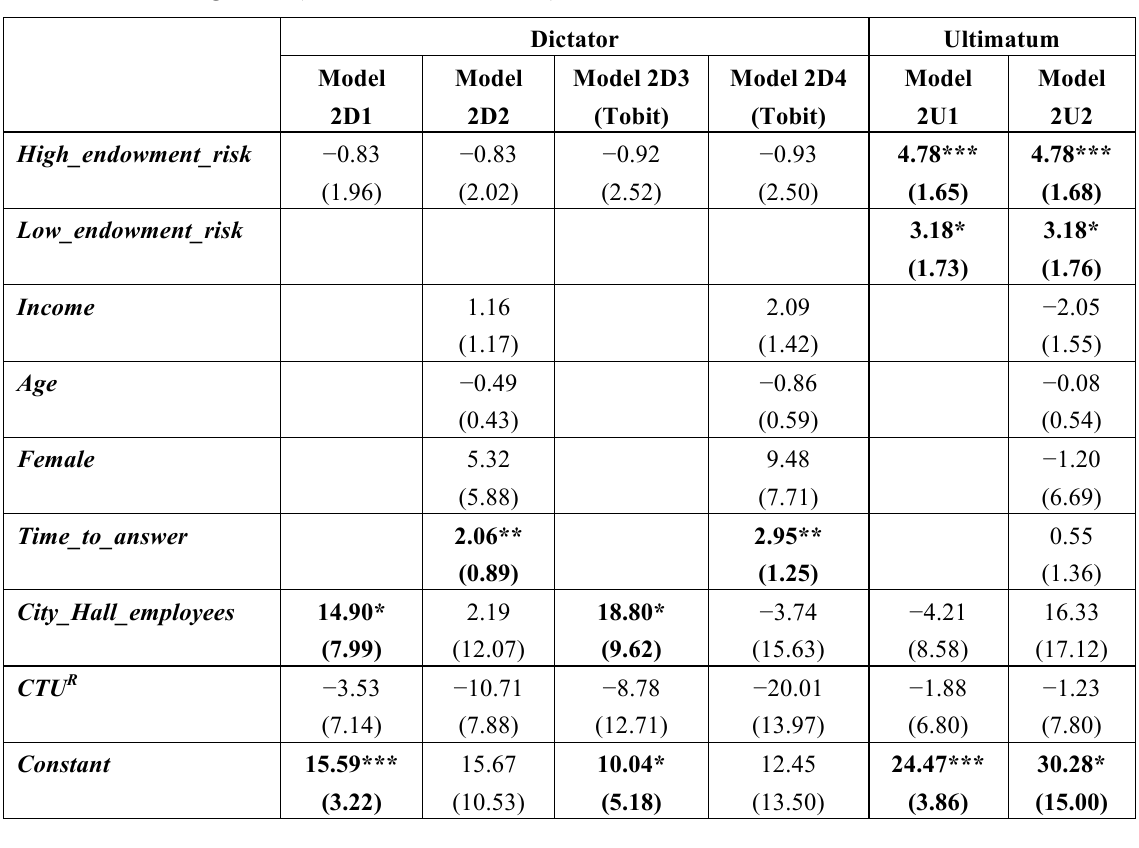
Table 7. Linear regression of giving on risk aversion and endowment risk in the Dictator and Ultimatum games (with clustered